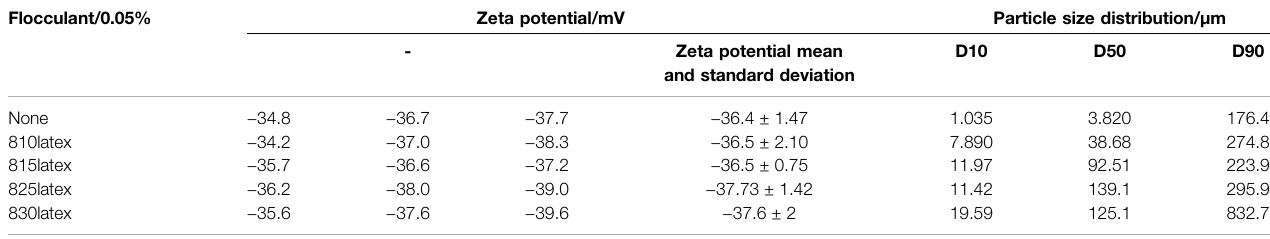
TABLE 4 | In fl uence of the organic fl occulant on the zeta potential and particle size distribution in Biodrill-A drilling fl uid. Flocculant/0.05%